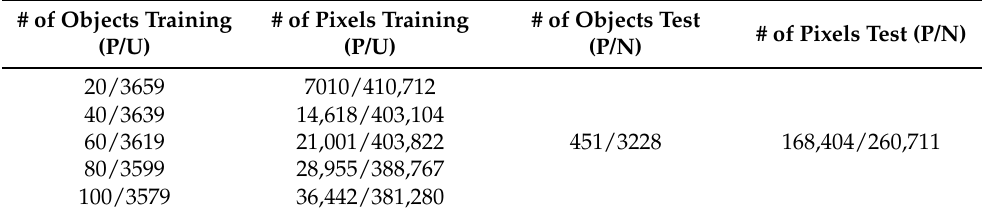
Table 2. Number of positive, unlabelled, and negative objects/pixels in the training and test set when the positive samples belong to the Cereals/Oilseeds land cover class.